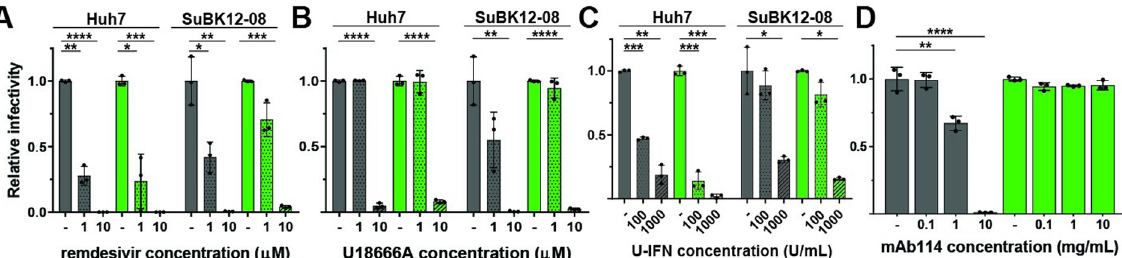
Fig 5. Antiviral testing of rLLOV comp . (A-D) Testing antiviral compounds against rEBOV-ZsG (gray bars) and rLLOV-ZsG (green bars) in human and bat cells. Huh7 and SuBK12-08 cells were pre-treated with the indicated concentrations of remdesivir (A) or the NPC-1 inhibitor U18666A (B) for 30 minutes, or with universal interferon (U-IFN) for 18 hours (C) prior to infection with rEBOV-ZsG or rLLOV-ZsG at an MOI of 0.1. Fluorescent images were taken at 2 dpi and mean fluorescence relative to infected cells pre-treated with vehicle control are shown. (D) Neutralization assay of rEBOV-ZsG and rLLOV-ZsG at an MOI of 10 using the indicated amounts of EBOV-neutralizing antibody mAb114. Fluorescent images were taken at 2 dpi and relative percentages of infected Huh7 cells are shown. Statistical differences were determined by two-way ANOVA (Prism), � p < 0.05, �� p < 0.01, ��� p < 0.001, ���� p <